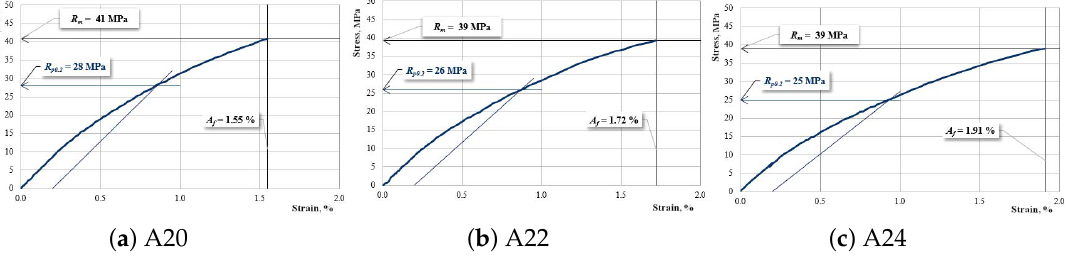
Figure 7. The characteristic curve for a sample: ( a ) A20; ( b ) A22; ( c ) A24.